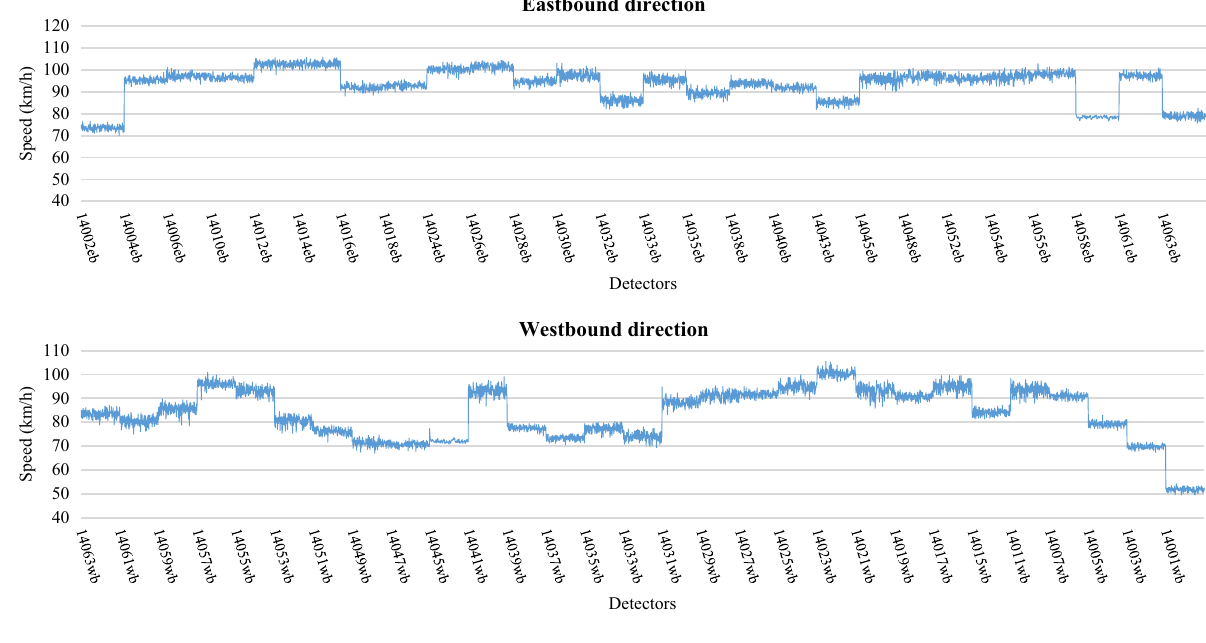
Figure 6. Simulated speed data used for eastbound and westbound directions.